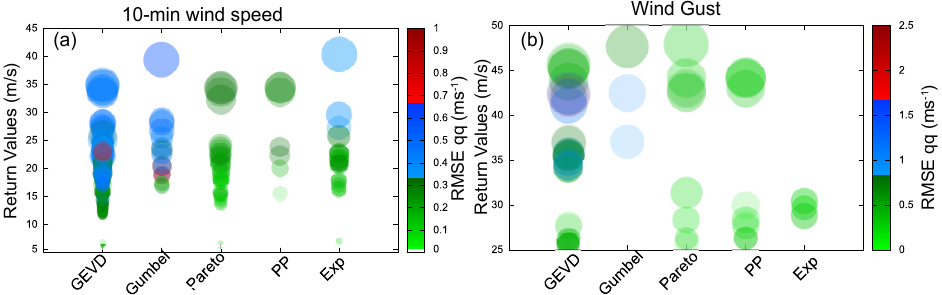
Figure 7. The 50-year 10-min wind ( a ) and wind gust ( b ) return values segregated according to the corresponding family distribution and as a function of the RMSE calculated from the q-q